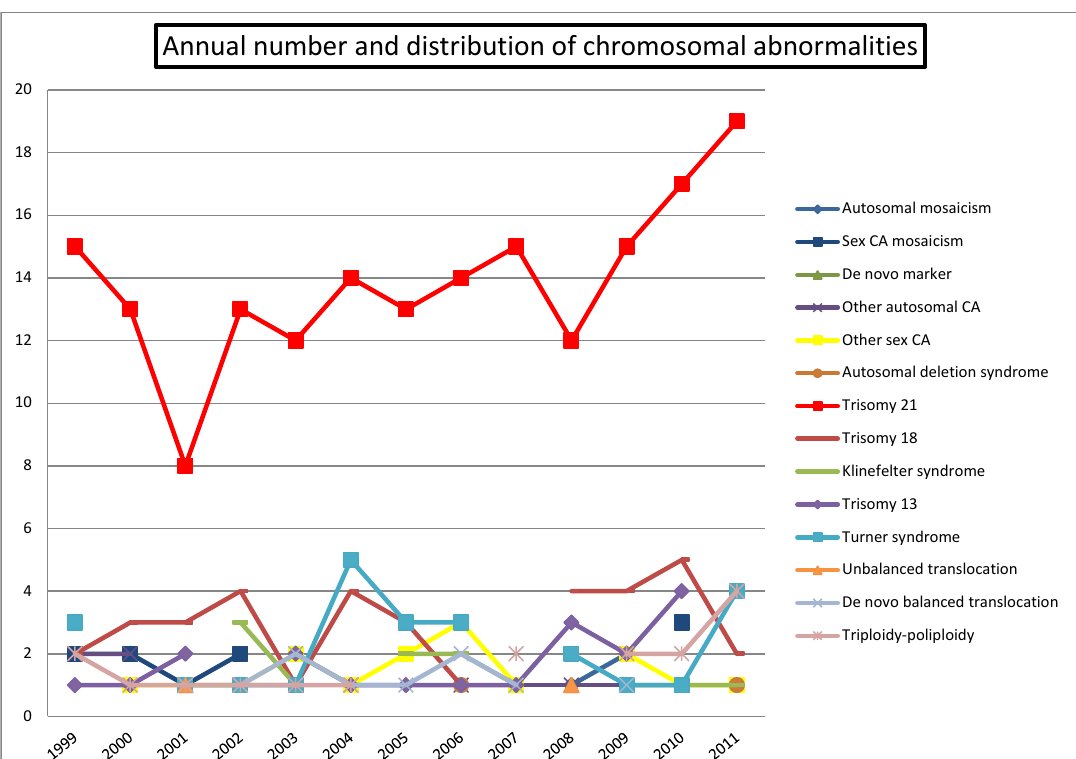
Figure 3. Annual number and distribution of chromosome